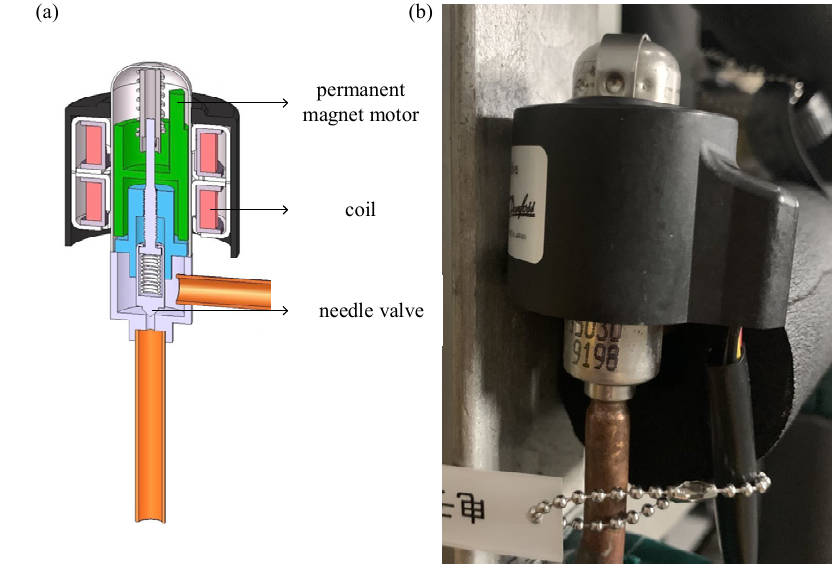
Figure 2. ETS 6 type EXV ( a ) cross ‐ sectional view [34]; ( b ) physical image.